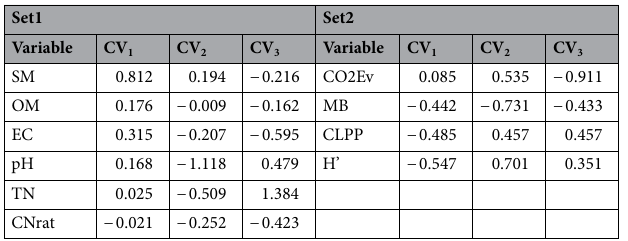
Table 2. Standardized correlations in Spring between the four canonical variables in the different columns and the variables in the two sets.